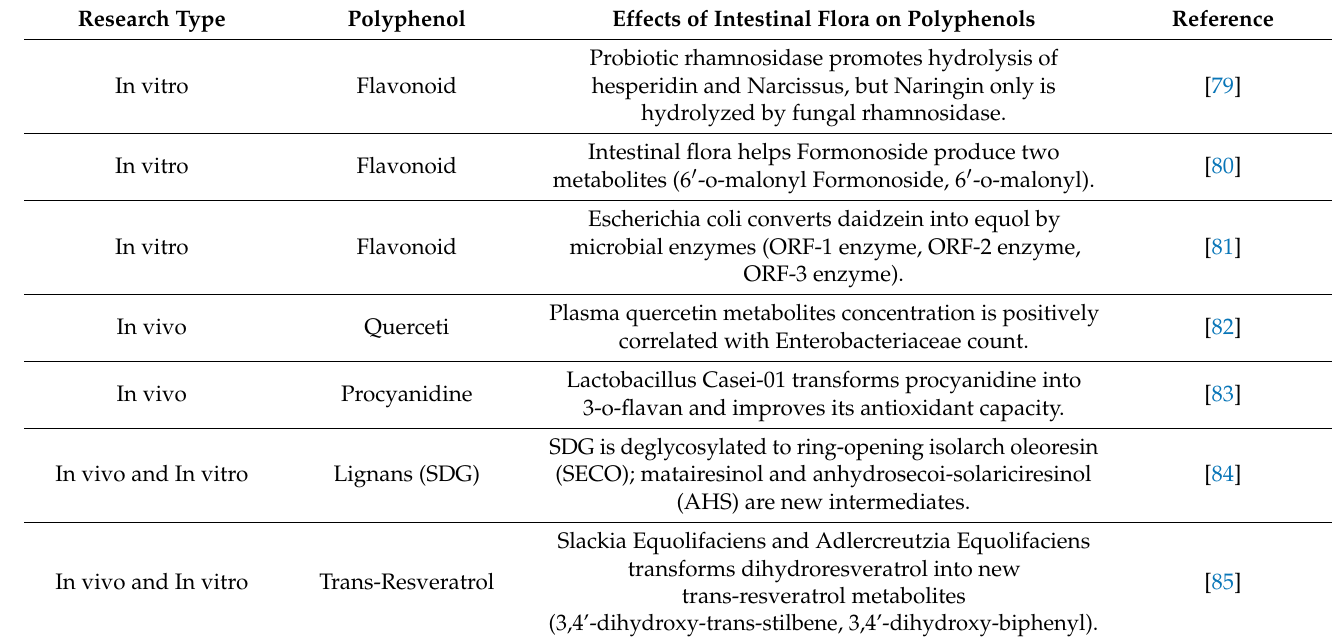
Table 1. The effect of intestinal flora on transformation and absorption of